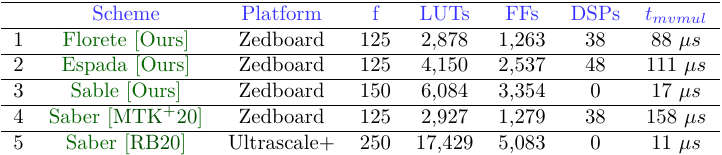
Table 6: Area and performance results of the polynomial arithmetic on hardware for our schemes and state-of-the-art